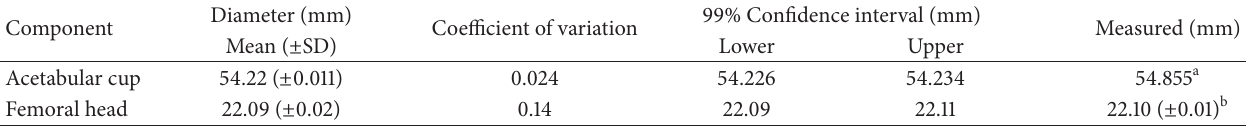
Figure 3: The top row contains the three 2D orthogonal projections showing the 3D spherical landmark located at the junction between the femoral component head and stem and the bottom row contains the three 2D orthogonal projections showing the 3D spherical landmark surrounding the femoral component head. (a) shows the axial projection, (b) the coronal, and (c) the sagittal. Table2:Acetabularcupandheaddiametermeasurements(themeanandmedianwerequiteclose)basedonexperimentalresultsandphysical